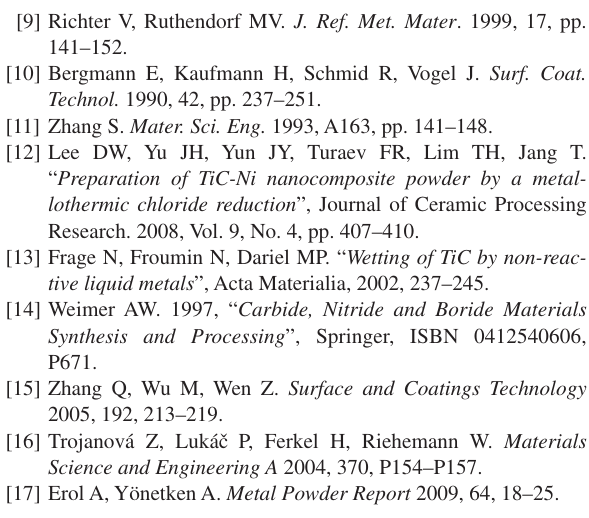
examination. It is also observed that various reactions oc- curred at the interface of contacting surfaces i.e., between Ni plating and the other constituents i.e., Fe and TiC pow- ders, easing the formation of composite